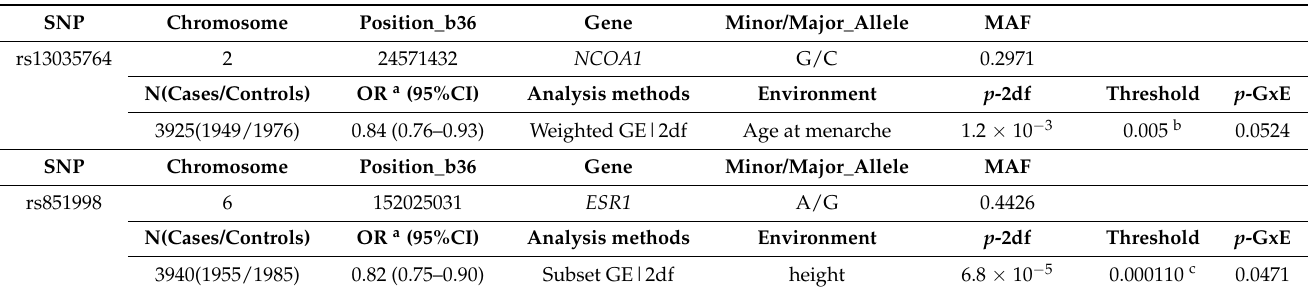
Table 2. Top two SNPs from the gene and environment interaction analysis between 11,555 SNPs involved in estrogen metabolism and 8 environmental factors related to estrogen, Seoul Breast Cancer